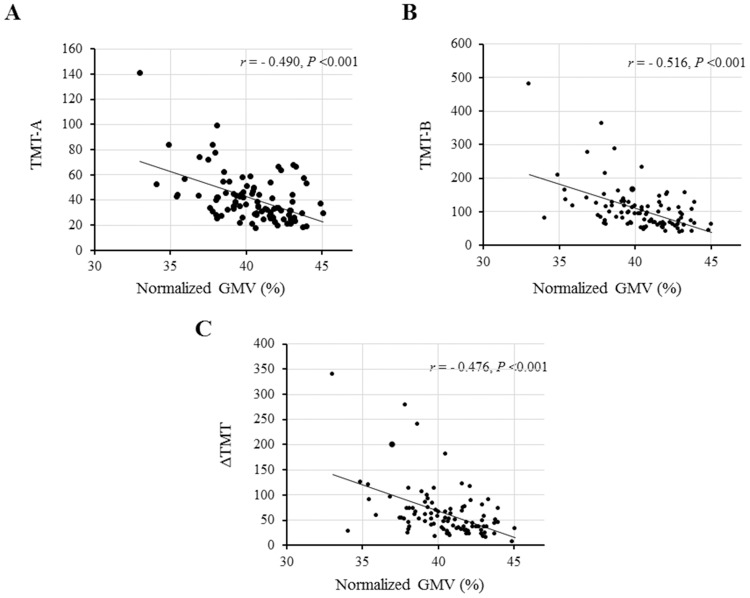
Correlations between normalized gray matter volume (GMV) and the scores (times in seconds) of Trail Making Test (TMT).Significant inverse correlations are found between normalized GMV and each score of TMT-A (A), TMT-B (B), and ΔTMT (C).